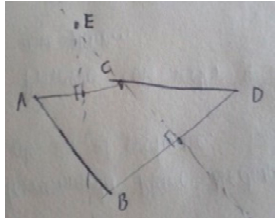
Figure 5. Static diagram of problem solution in plane.